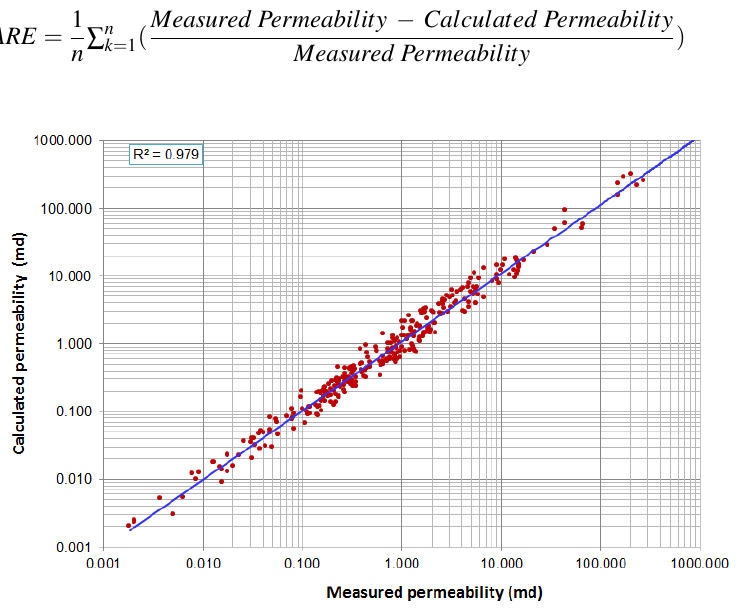
Figure 9. The calculated permeability versus the measured